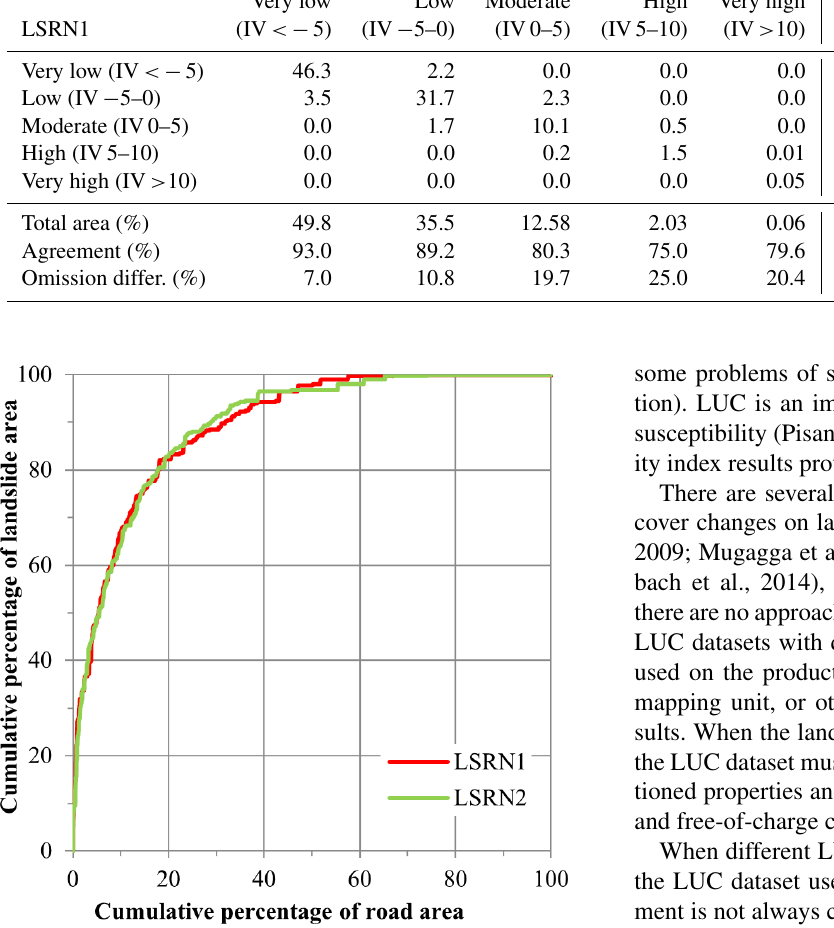
Figure 11. Success rate curves of LSRN1 and LSRN2 models.